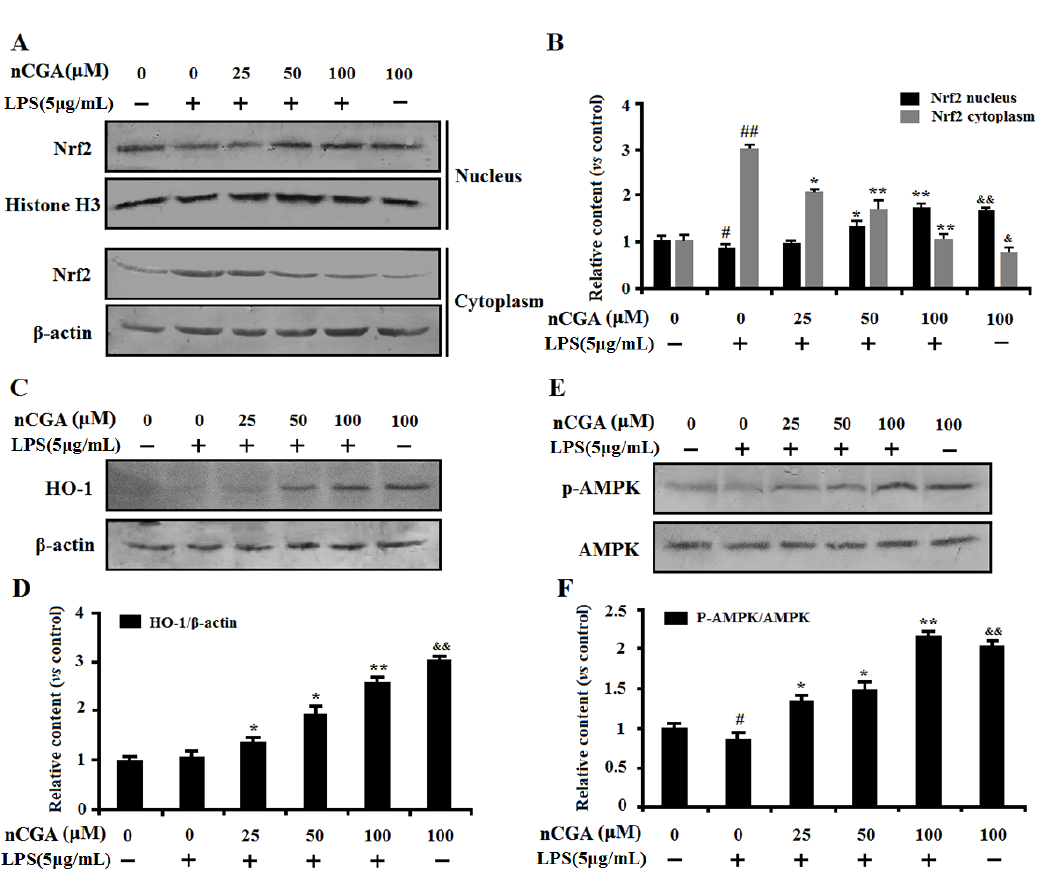
Figure 5. Effects of nCGA on regulation of Nrf2 and AMPK against LPS-induced inflammatory responses in A549 cells. Cells were pretreated with or without various concentrations of nCGA (0, 25, 50, 100 µ M) for 2 h before incubation with LPS (5 µ g / mL) for another 24 h. ( A , B ) The nuclear and cytoplasmic Nrf2 were measured by Western blotting and the quantitative analysis were performed by normalization with Histone H3 and β -actin, respectively. ( C , D ) Western blot analysis showed the protein expression level of HO-1 was normalized with β -actin. ( E , F ) To investigate the e ff ect of nCGA on AMPK signaling pathway, the level of p-AMPK was determined by Western blot analysis. The values represent the mean ± SD of three independent experiments, significant di ff erences between di ff erent groups. # p < 0.05, ## p < 0.01 vs. control group, * p < 0.05, ** p < 0.01 vs. LPS alone, & p < 0.05, && p < 0.01 nCGA treated group vs. control group.